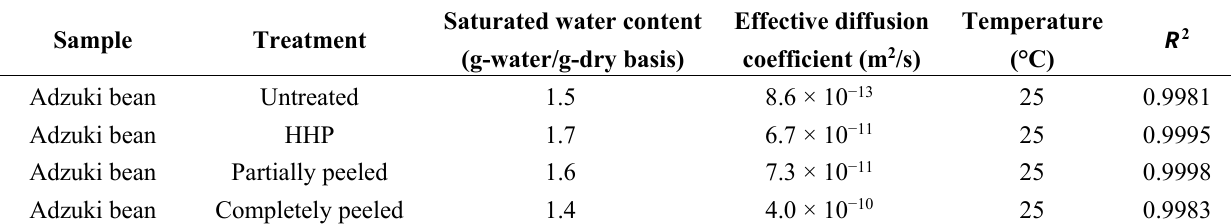
Table 2. Saturated moisture contents and effective diffusion coefficients of untreated control, HHP (200 MPa, 10 min)-treated adzuki beans, partially peeled beans, and completely peeled beans. All water absorption experiments were carried out at 25